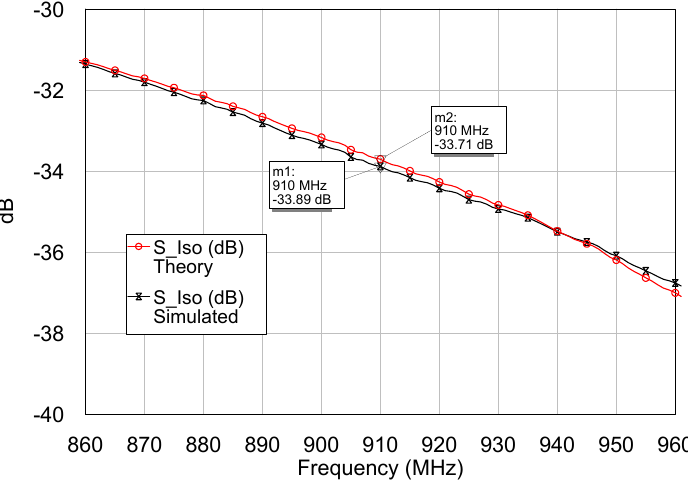
Figure 9. Simulated isolation performance and theoretical results comparison.